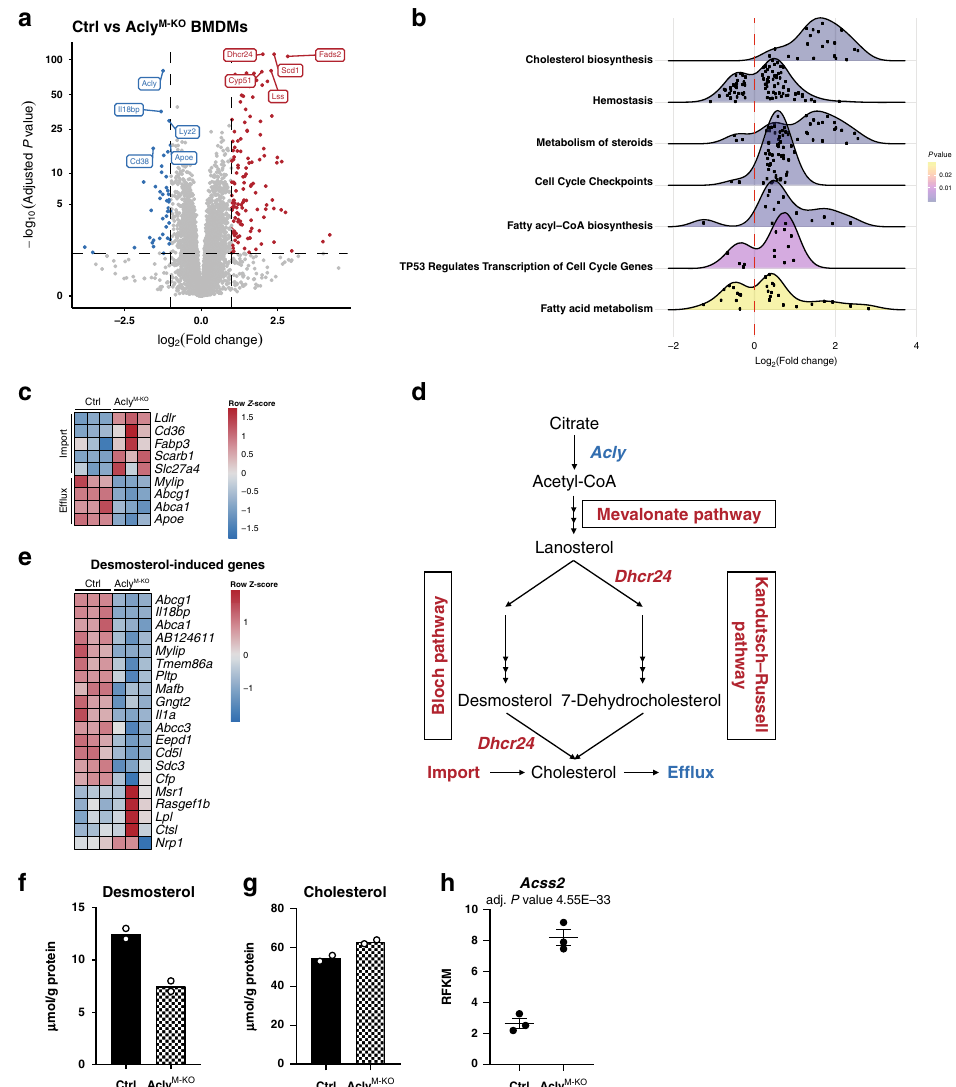
Fig. 6 Acly M-KO macrophages exhibit deregulated cholesterol biosynthesis. a Volcano plot with up- or downregulated genes in Acly- de fi cient macrophages (BMDMs) highlighted in red or blue, respectively. b Ridgeline plot of signi fi cantly enriched Reactome pathways. Log 2 FC distributions of member genes are plotted on the x axis. Color of the distributions represents enriched pathway P value. c Expression of genes involved in import/transport of cholesterol and fatty acids, and genes that promote cholesterol ef fl ux. d Schematic view of cholesterol metabolism and the effect of Acly de fi ciency (red indicating upregulation; blue downregulation). e Desmosterol levels in control and Acly-de fi cient macrophages. f Genes previously found to be induced by desmosterol, plotted in a heatmap for control and Acly M-KO macrophages. g Cholesterol levels in control and Acly-de fi cient macrophages. h Acss2 expression in control and Acly-de fi cient macrophages. Values represent mean from n = 2 technical replicates from three pooled mice e , g , or mean ± SEM n = 3 technical replicates from three pooled mice ( h ). Source data are provided as a Source Data fi le e , g or deposited in GSE126690 ( a – d , f , h